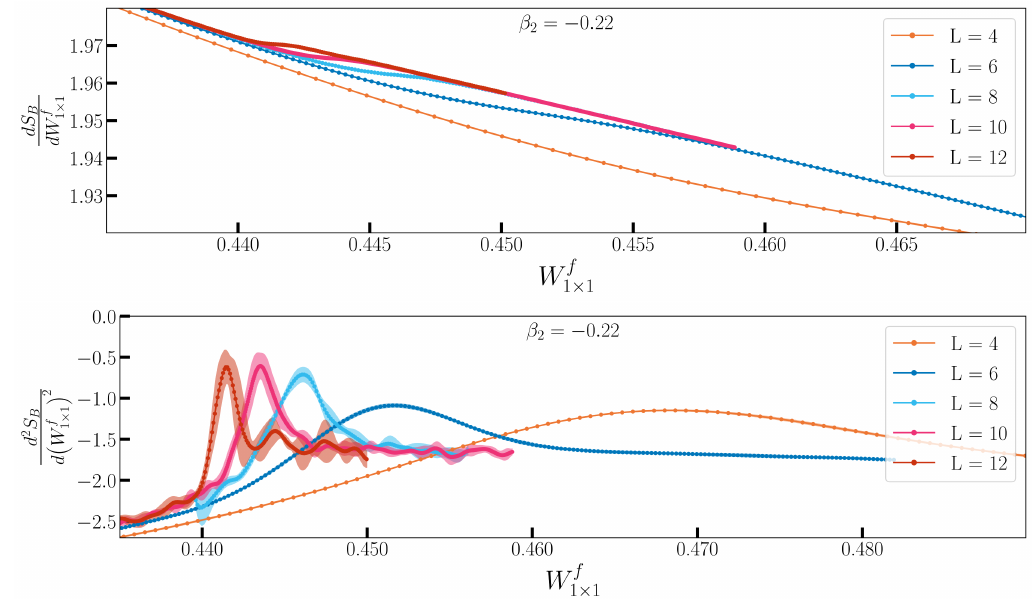
Figure 11 . First ( top ) and second derivative ( bottom ) of the entropy as a function of W f different lattice sizes and β 2 = − 0 . 22 . The colored region around the markers is an estimate of the error based on independent